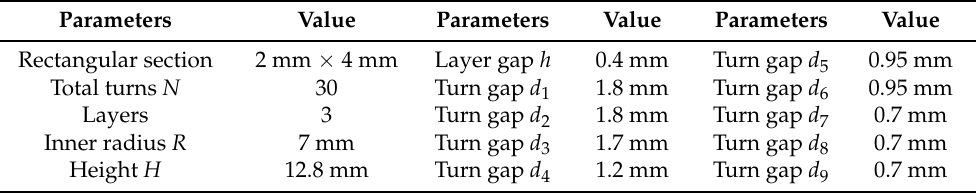
Table 1. Size parameters of a three-layer coil with variable turn gaps.